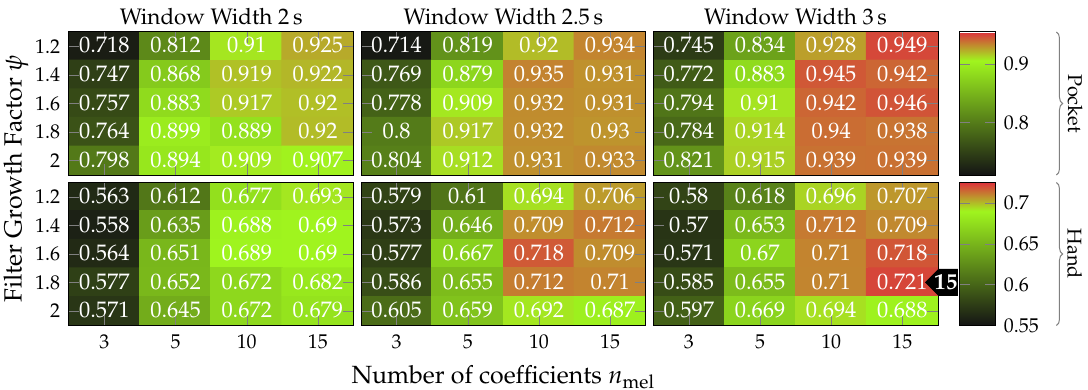
Figure 22. Results of benchmarks done for the hyperparameters n mel and ψ , controlling number, as well as growth of filters in the used MFCC filter-bank respectively, for both pocket-case and